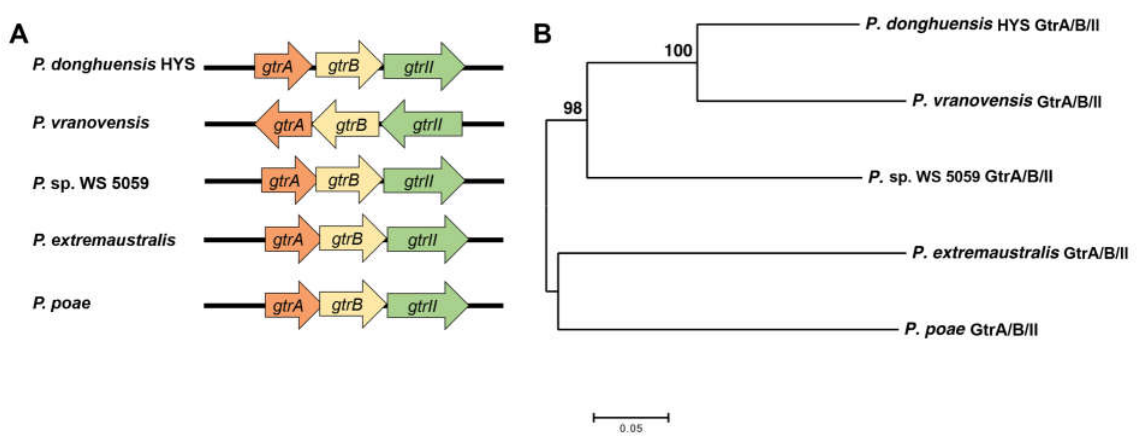
Figure 2. Arrangement and phylogenetic analysis of GtrA/B/II in Pseudomonas . ( A ) Arrangement of GtrA/B/II in five strains. ( B ) Phylogenetic analysis of P. donghuensis HYS GtrA/B/II using amino acid sequences with MEGA7.0 program. Table 1. Information on strains with the same arrangement of GtrA/B/II as P. donghuensis HYS. Species